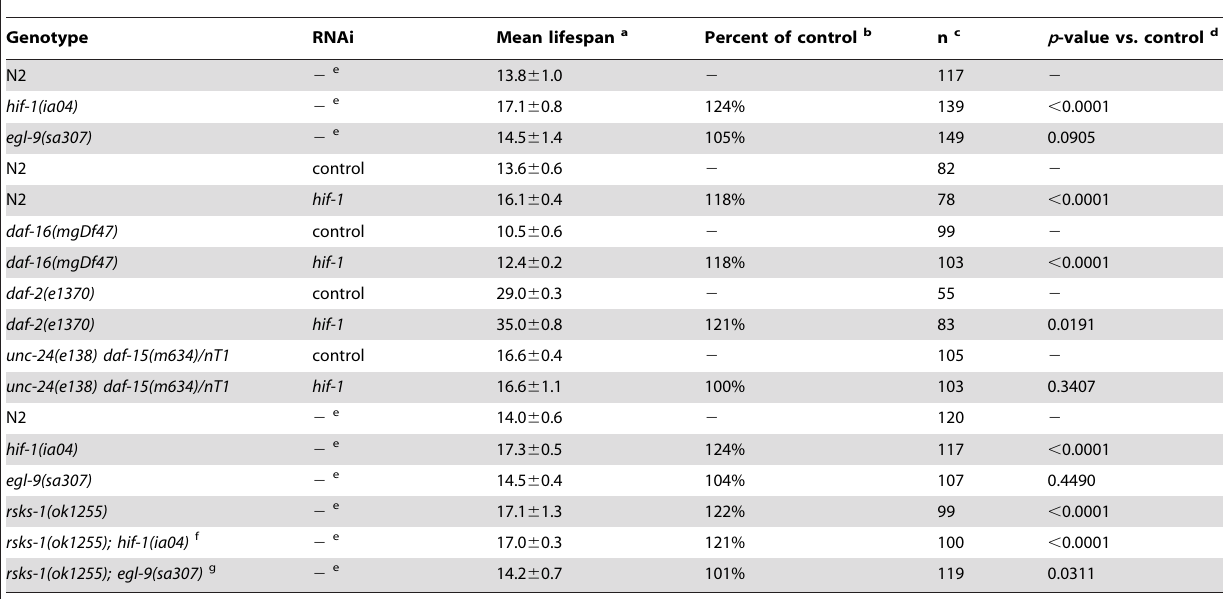
Table 1. HIF-1 functions in the TOR-S6K pathway to modulate C. elegans lifespan.